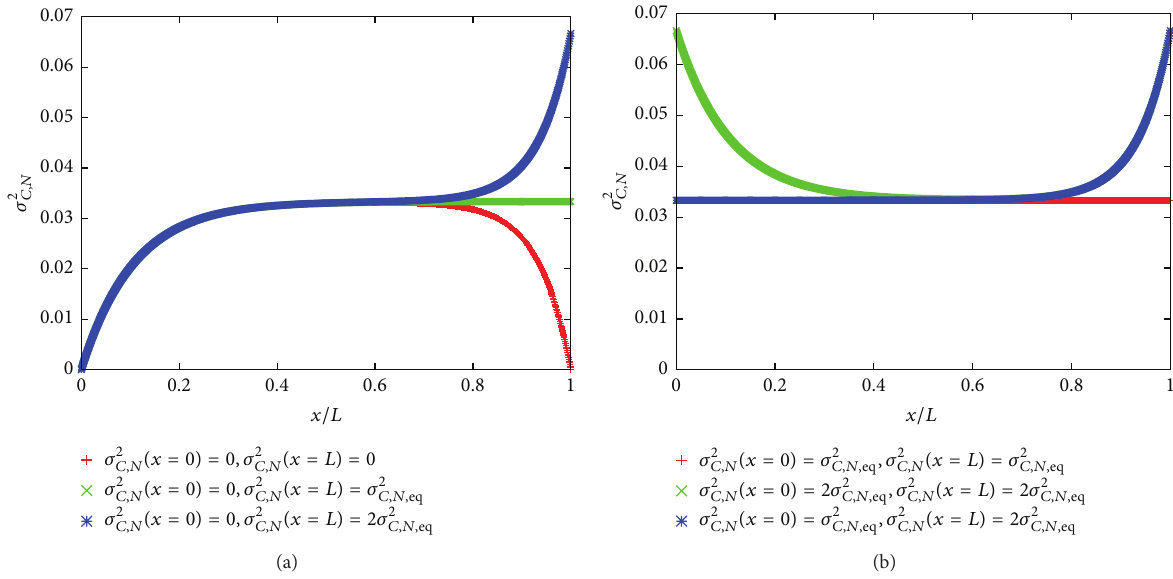
Figure 2: Reference nondimensional solution with sensitivity analysis on the boundary nondimensional values 𝜎 2 𝐶,𝑁 , which are alternatively equal to 0, 1/30, and 1/15 (all the independent combinations are